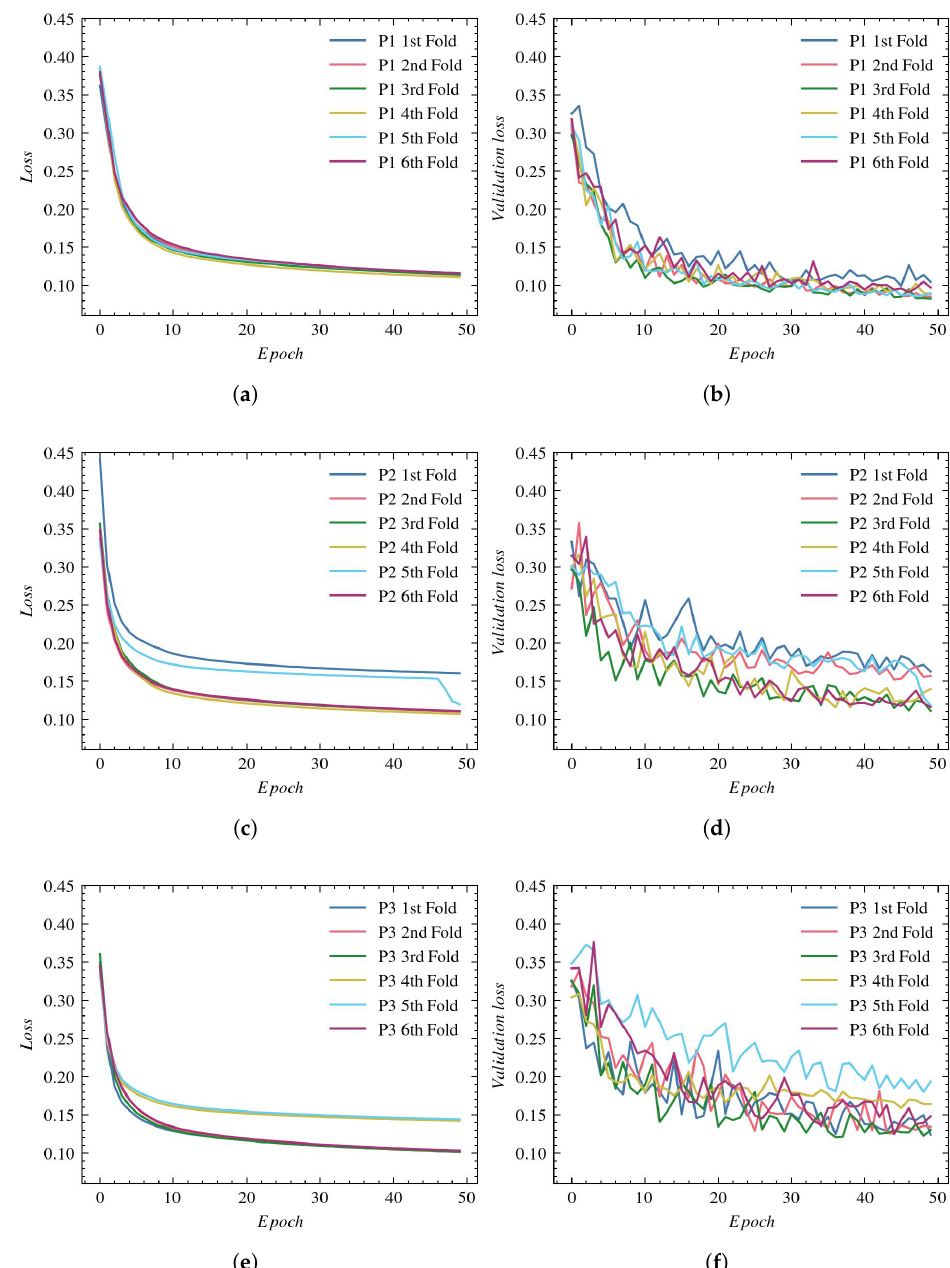
Figure 6. Loss plots for UNet architecture: ( a ) training using P1, ( b ) validation using P1, ( c ) training using P2, ( d ) validation using P2, ( e ) training using P3, and ( f ) validation using